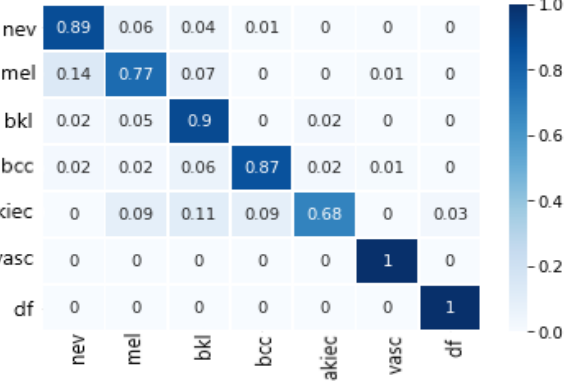
Figure 3. Confusion matrix for DenseNet169.